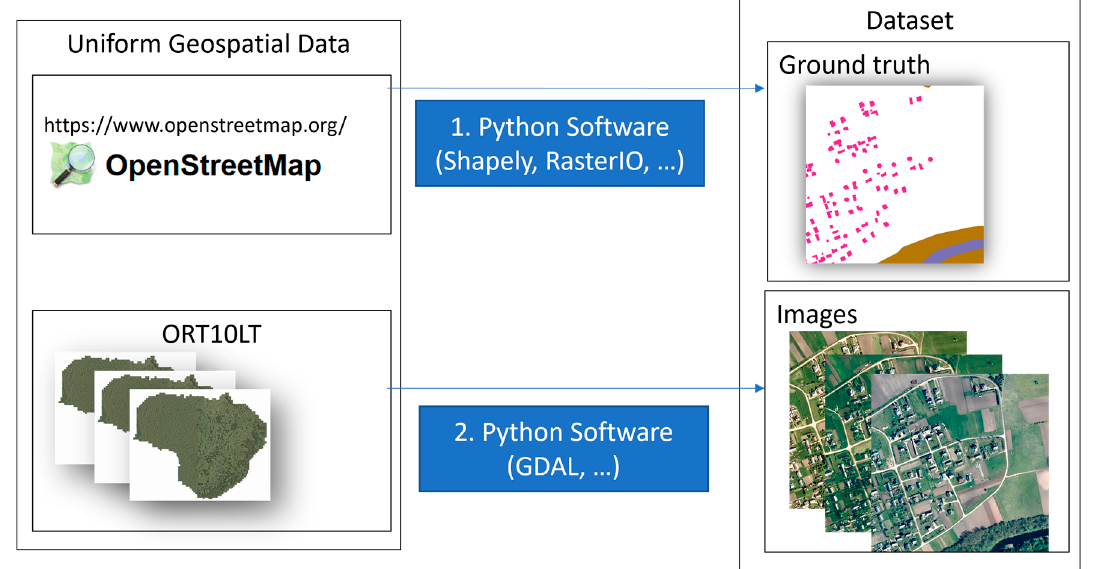
Figure 4. The scheme of two ‐ step data labeling process.